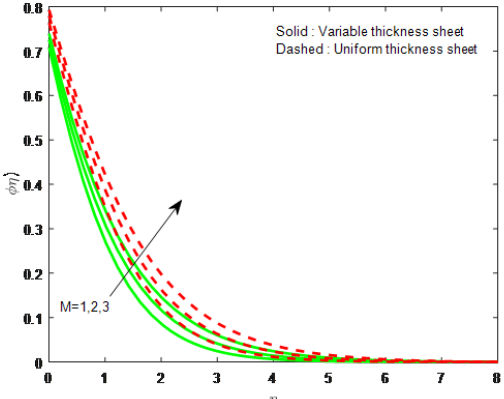
Fig. 4: Influence of M on concentration field